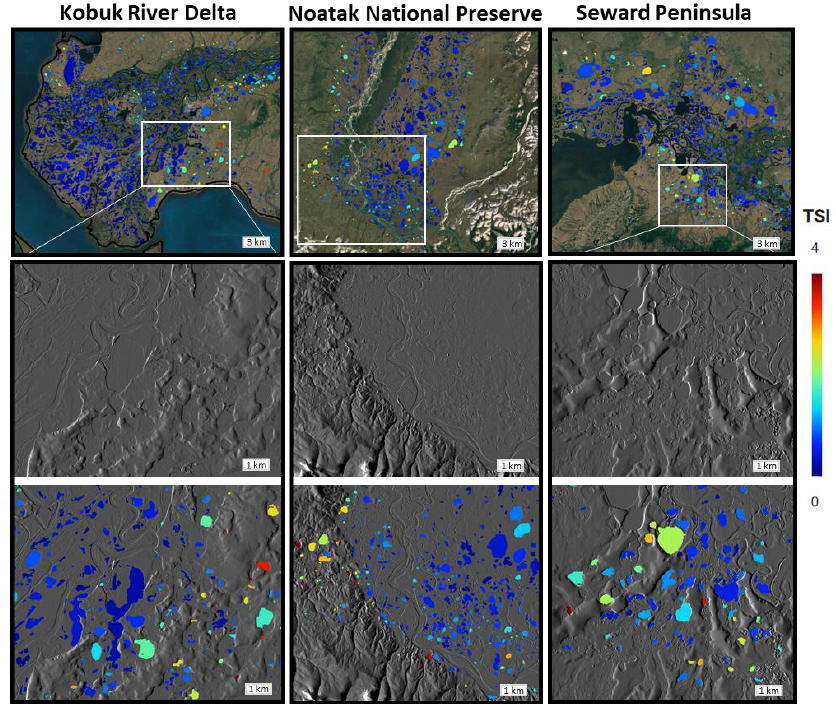
Figure 4. Examples of the Thermokarst lake Settlement Index (TSI) projected on Landsat scenes (top row) within the Kobuk River Delta (left column), southwestern Noatak National Preserve (middle column), and central Seward Peninsula (right column). The TSI is overlaid on a greyscale hillshade surface computed with the Arctic Digital Elevation Model (DEM) (bottom row).